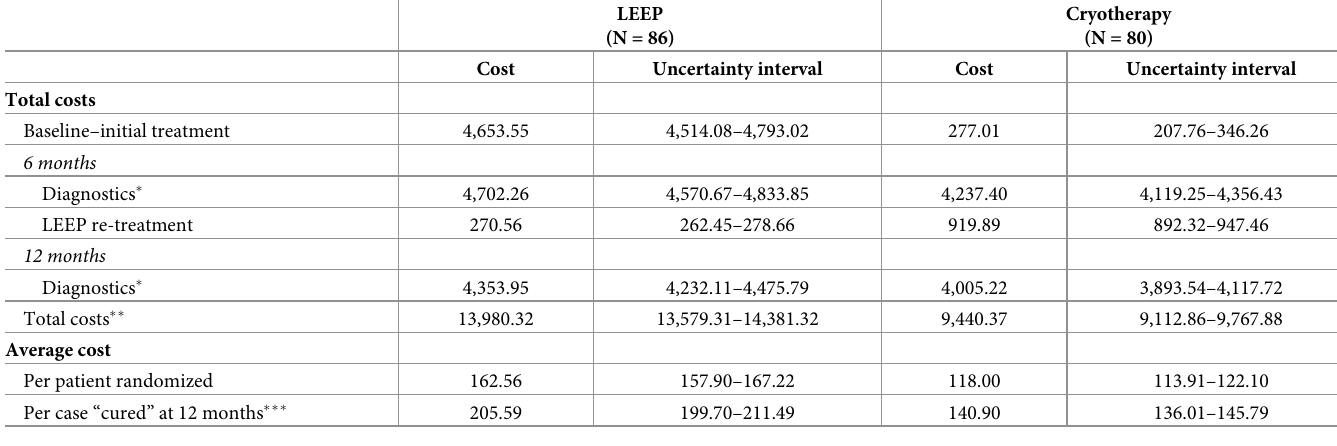
Table 5. Total and average costs of treating analytical cohort for CIN 2+ (US$ 2015) (Functional Limit scenario), intention-to-treat analysis.